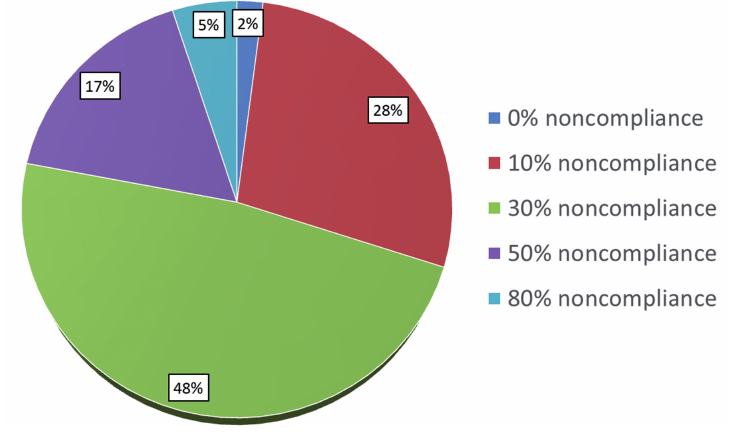
figure 1 - perceived rate of noncompliance with clinical follow-up for patients with Stage I testicular seminoma among US radiation oncologists.